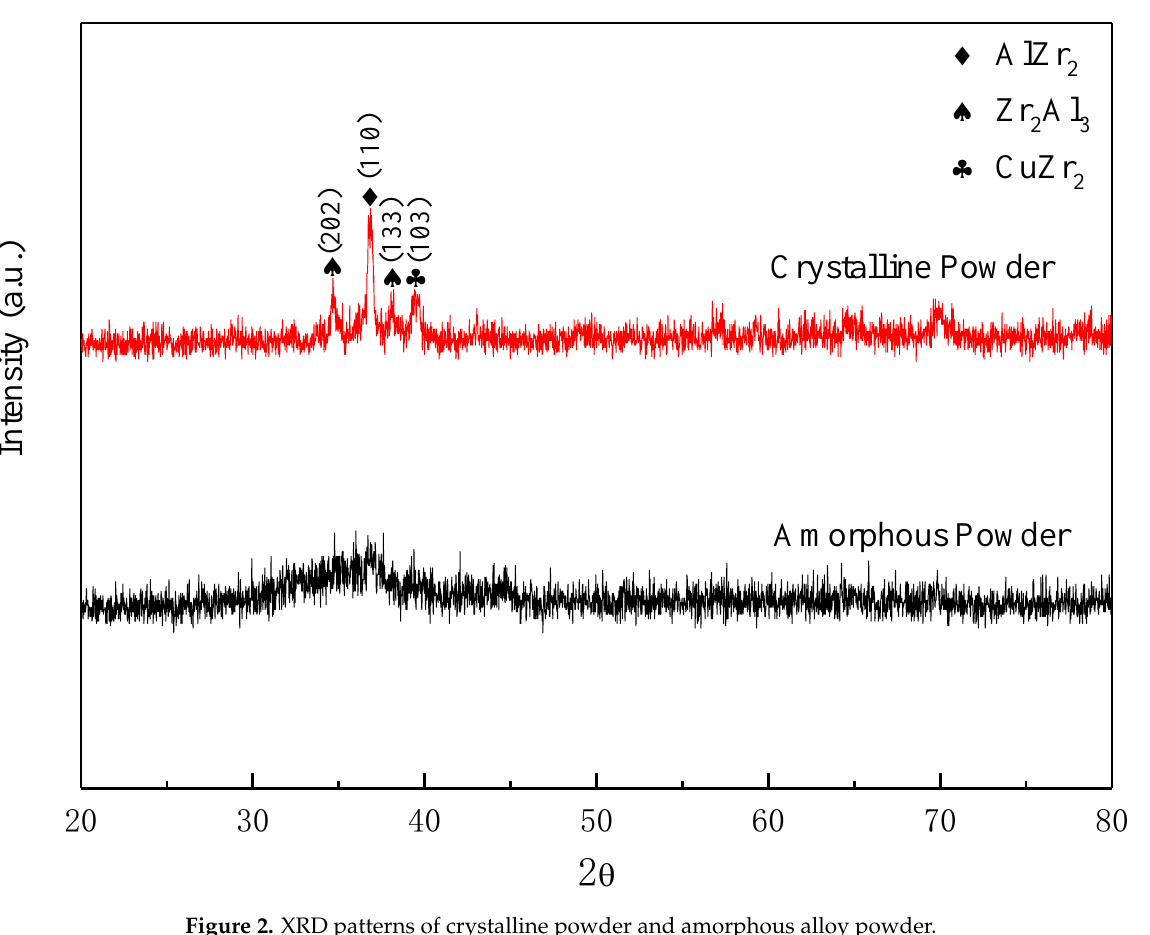
Figure 2. XRD patterns of crystalline powder and amorphous alloy powder.